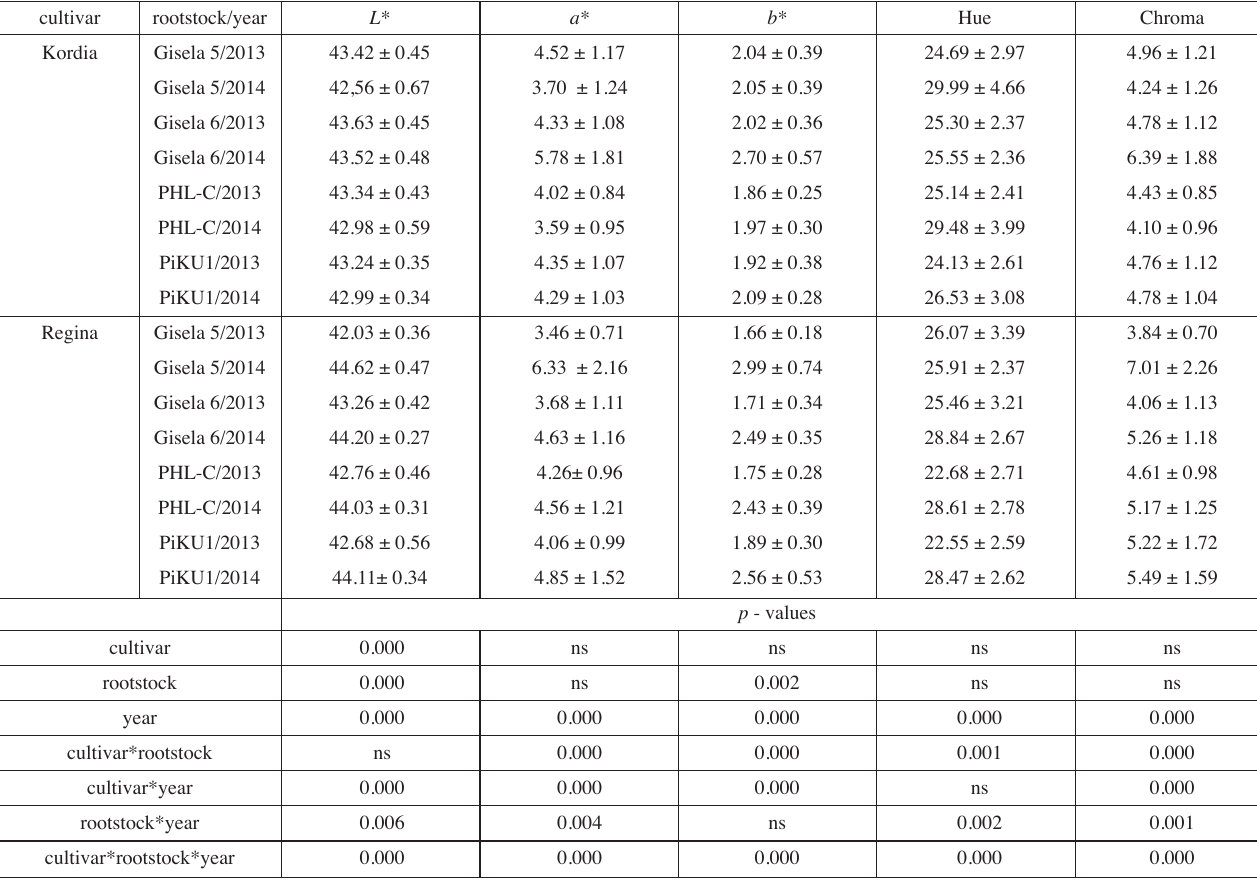
Tab. 4: Colour characteristics of sweet cherry cvs ‘Kordia’ and ‘Regina’ grafted on 4 different rootstocks, average values for 2013 and 2014*